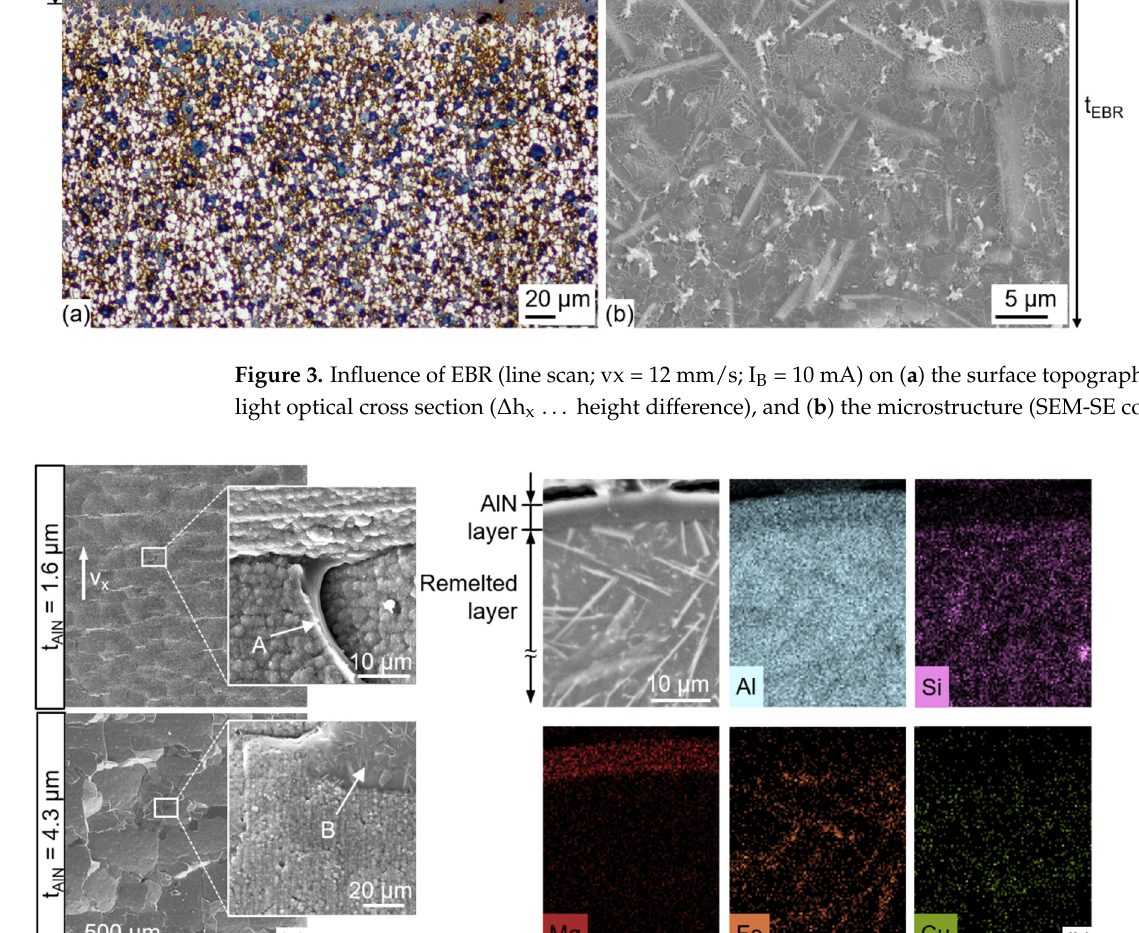
Figure 4. Influence of both the initial AlN layer thickness t AlN and the beam current I B (line scan; v x = 12 mm/s) on the surface deformation: ( a ) t AlN = 1.6 µm at I B = 10 mA (top); t AlN = 4.3 µm at I B = 12 mA (bottom); ( b ) element distribution after EBR (I B = 12 mA) measured by means of cross-sectional analysis using EDS.